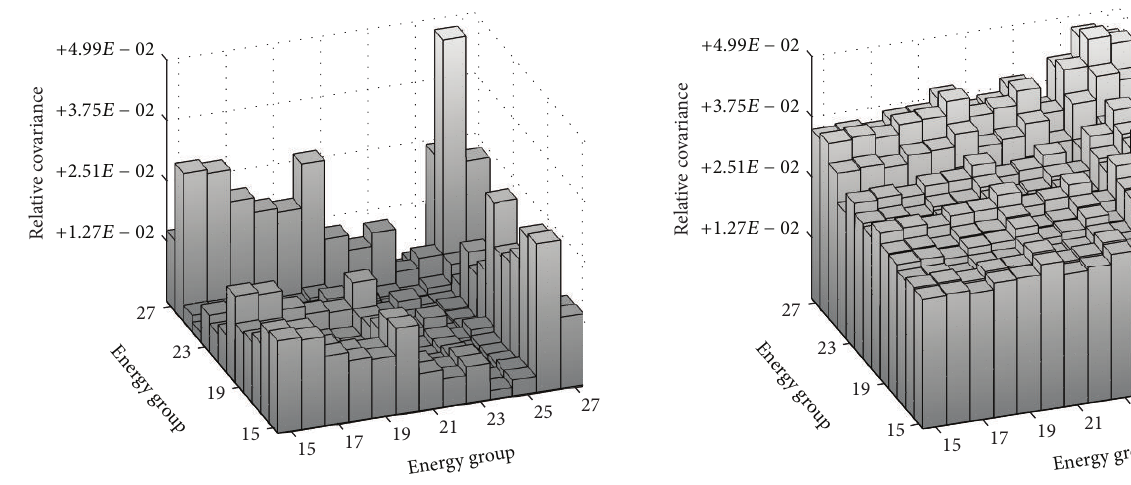
Figure 11: 𝜎 U 238 𝑒 covariance at infinite dilution.